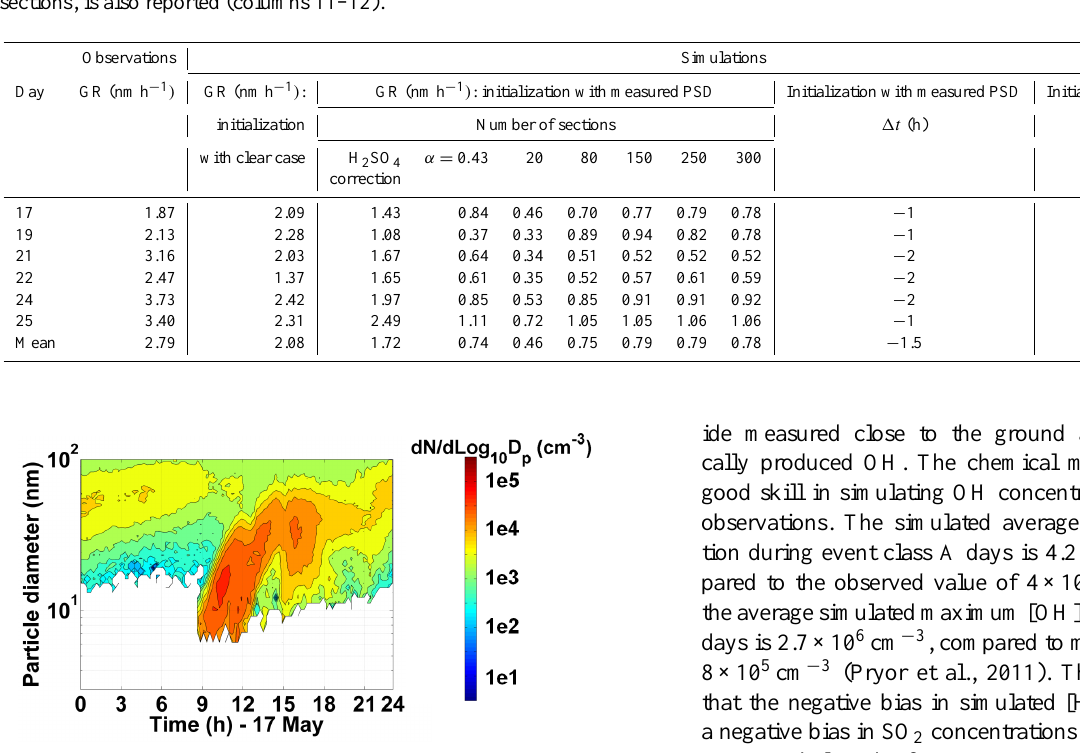
Table 5. Measured and simulated growth rates [nm h − 1 ] for class A events. Column 1 indicates the day in May 2008, column 2 the observed growth rates (GR) and column 3 shows simulated GR computed initializing the model with clear atmospheric conditions and setting 250 sections. Columns 4 and 5 refer to GR simulated initializing the model with measured PSD and setting 250 sections when the sulfuric acid (H 2 SO 4 ) and mass accommodation coefficient ( α) correction are applied respectively, as described in Sect. 3.2. Columns 6–10 summarize the results from the sensitivity analysis of simulated growth rates on the number of sections (20, 80, 150, 250 and 300 sections) when the model is initialized with measured PSD. The timing between measured and simulated maximum 6-30nm particle number concentrations ( 1t = t obs − t sim ) , computed initializing the model each day with the measured PSD and with clear atmospheric conditions setting 250 sections, is also reported (columns 11–12).